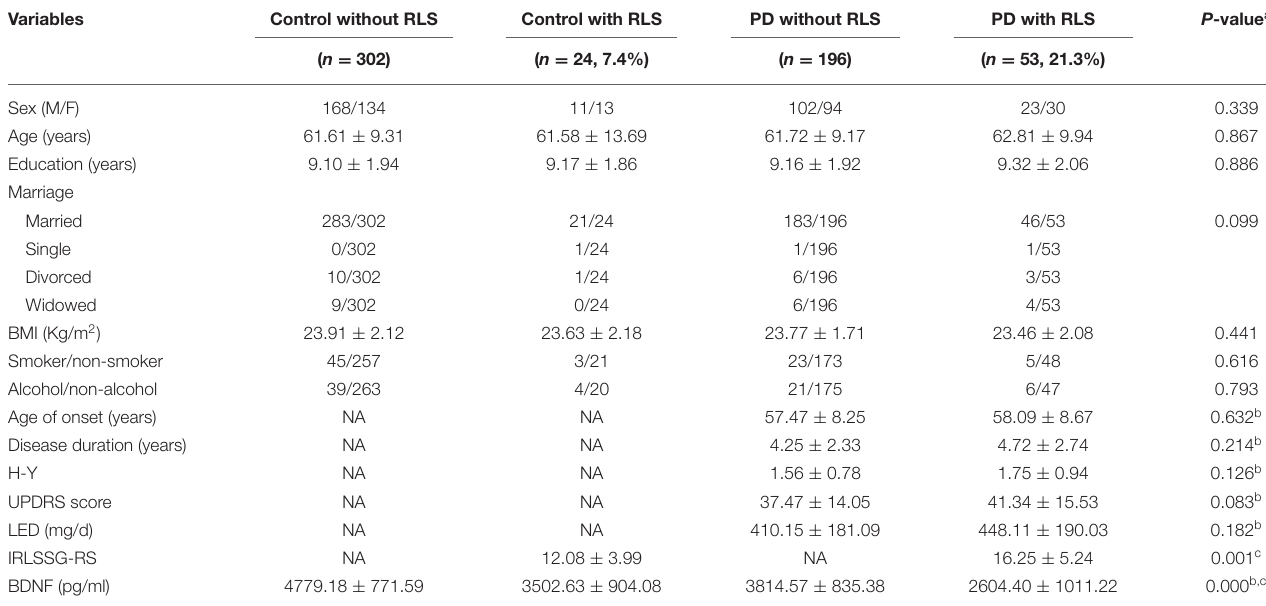
TABLE 1 | Clinical characteristics and demographic details of Parkinson’s disease patients with RLS and without RLS and controls. Variables Control without RLS Control with